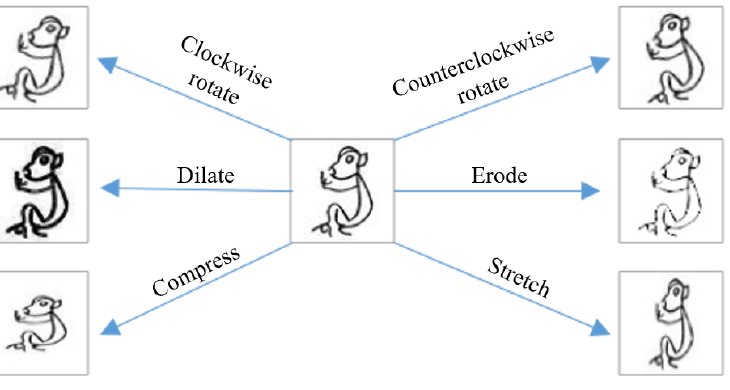
Figure 5. An instance of data